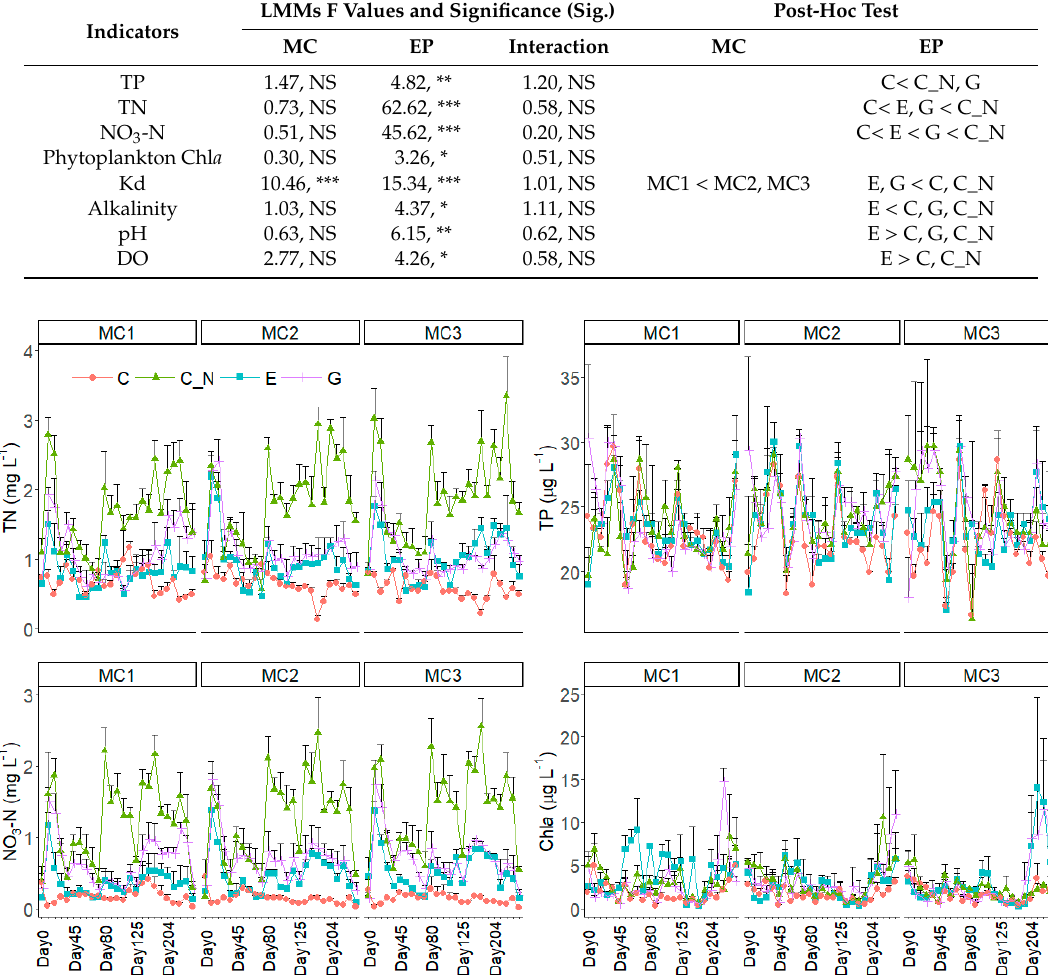
Table 1. Statistical summary of results of the linear mixed models (LMMs) on the e ff ects of macrophyte community (MC: MC1, MC2 and MC3) and extreme precipitation (EP: control (C), extra nutrient loading (C_N), extreme treatment (E) and gradual treatment (G)) on physico-chemical parameters including total phosphorus (TP), total nitrogen (TN), nitrate (NO 3 -N), phytoplankton Chl a , alkalinity, pH, light attenuation coe ffi cient (Kd) and dissolved oxygen (DO). The post-hoc test was conducted by the Tukey method. NS = not significant; * = p < 0.05; ** = p < 0.01; *** = p < 0.001. LMMs F Values and Significance (Sig.)